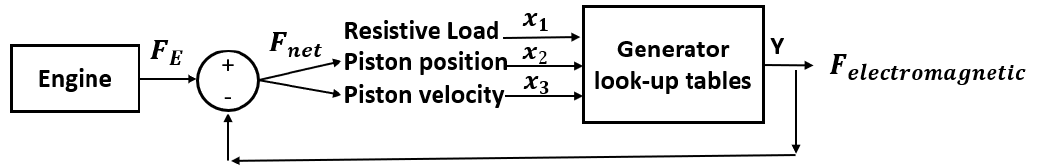
Figure 6. Flowchart of novel integrated model in AMESim.